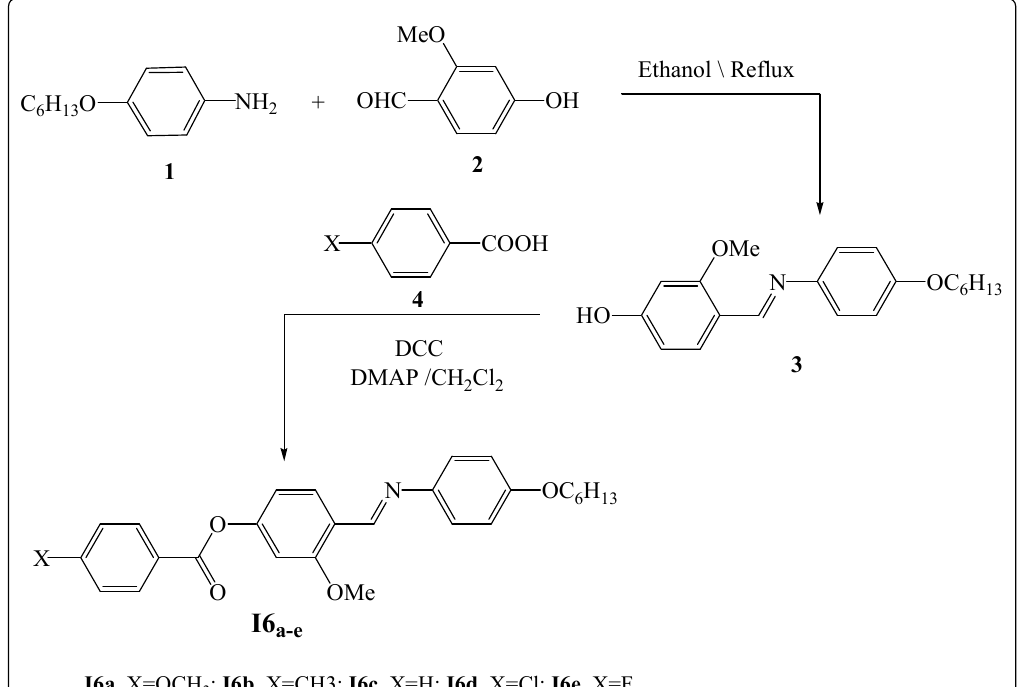
Figure 1. Prepared homologues series, I6 a–e